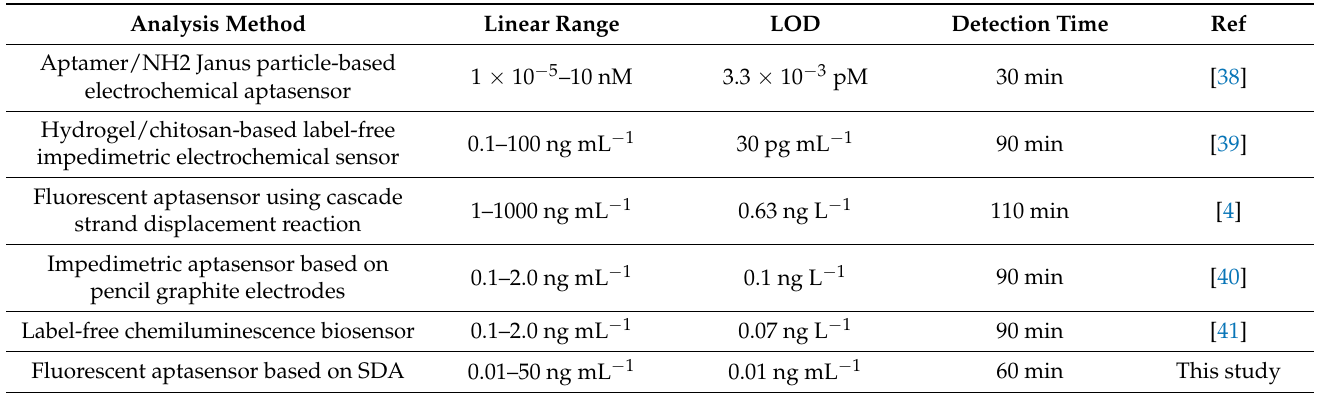
Table 2. Comparison of the SDA-based fluorescent aptasensor with other technologies based on aptamers for OTA detection.